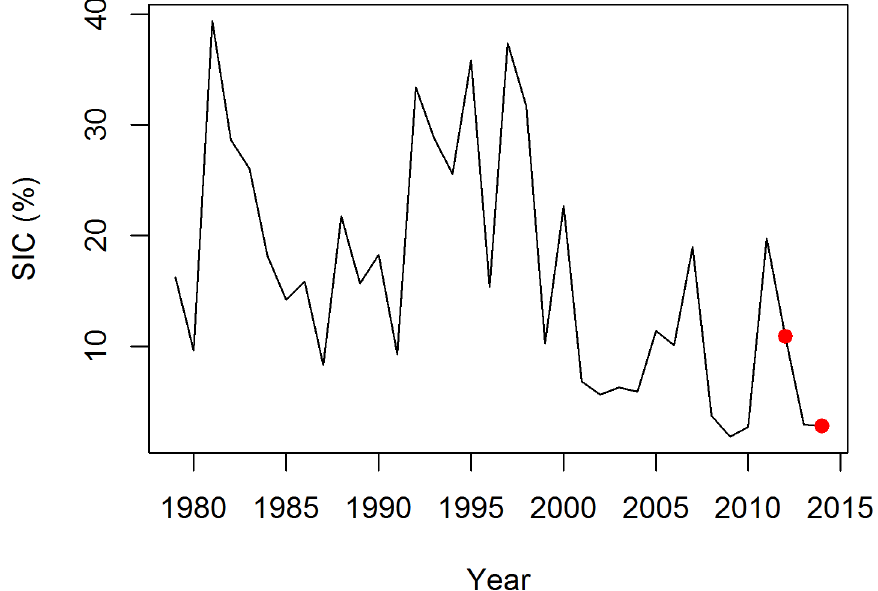
Fig 2. Mean sea ice concentration (SIC) in a 150x200 km area off Ukaleqarteq, East Greenland. The mean value was calculated for each year between 15 July and 15 August across 1979 – 2014 (reprocessed sea ice concentration dataset of the EUMETSAT OSI SAF). Red dots indicate mean SIC values for 2012 and